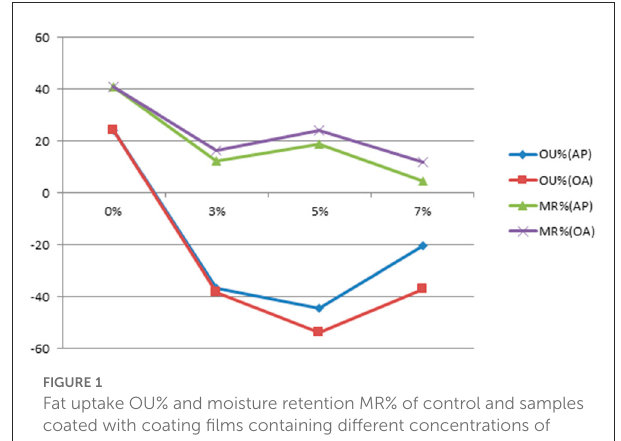
(control). Figure 3 has shown the scores for the appearance and color of the samples coated with orange albedo ranging from